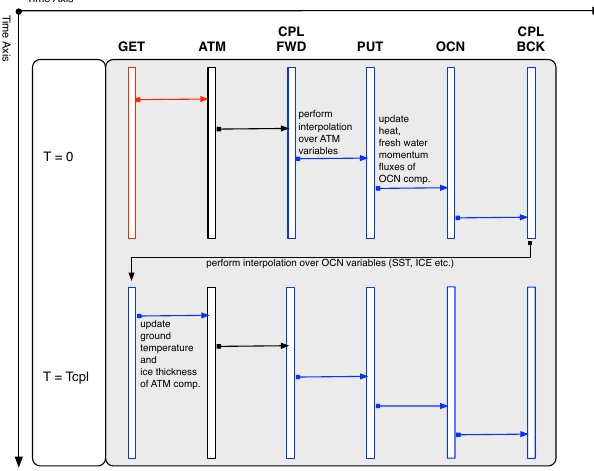
Fig. 2. Execution order of the model code. The black solid rect- angles represent the component codes that always run. The blue and red rectangles indicate the sub-routines that can execute only when the model coupling is activated. The red rectangle indicates the skipped code